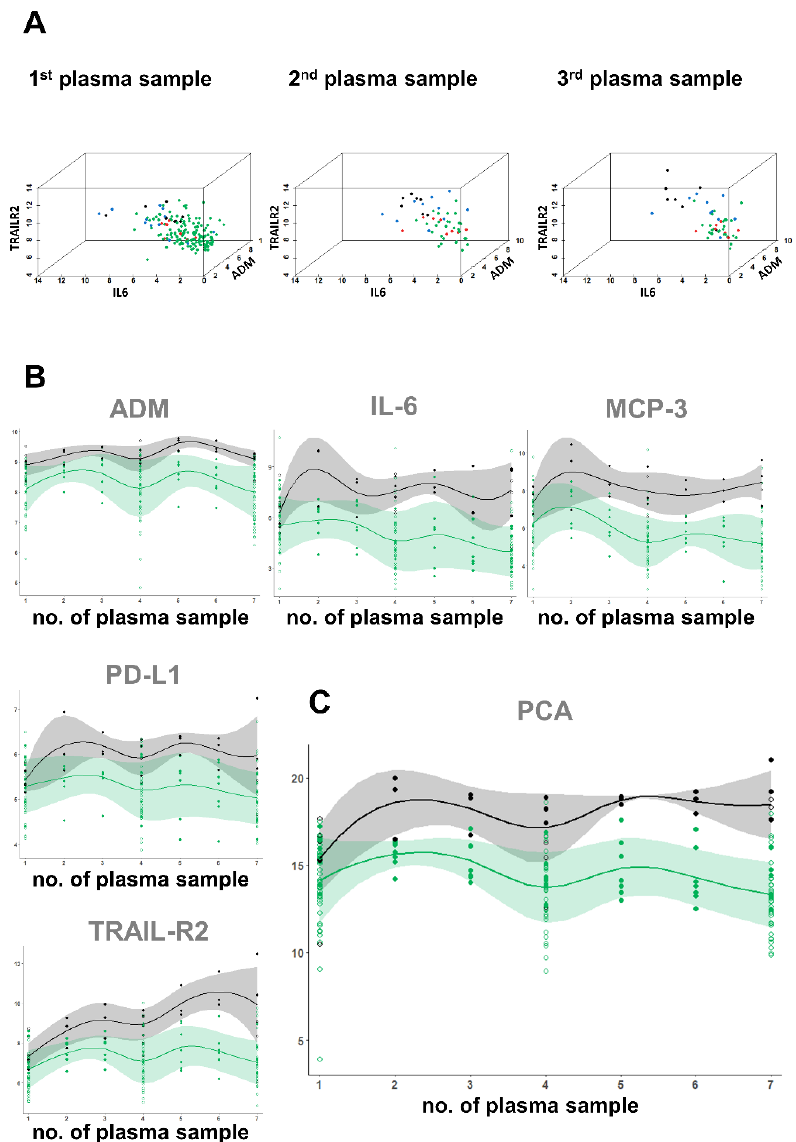
Figure 6. Illustration of predictive protein values and kinetics as well biological variation of proteins during hospital stay—( A ) three-dimensional illustration of predictive protein values. Green dots: non-hospitalized COVID-19; red dots: hospitalized COVID-19 with ICU admission; blue dots: hospitalized COVID-19 with ICU admission and requirement for mechanical ventilation; Black dots: COVID-19 with fatal outcome. ( B ) Kinetics of the five selected markers separately (ADM, IL-6, MCP-3, PD-L1, TRAIL-R2) and ( C ) the PCA based on the combination of the analytes. The x -axis represents seven different time points of plasma procurement, with the first (1) taken at the ED and the seventh (7) isolated prior to discharge or death of the patient. Samples two to six were isolated during the hospital stay at approximately similar time intervals. Depicted are values of all n = 53 hospitalized COVID-19 patients with three time points. For n = 10 (solid dots) patients plasma samples at seven time points were analyzed. Open dots represent patients with three time points. Green dots = discharged patients, black dots = patients with fatal outcome. Shown are data for individual COVID-19 patients with survival (solid green dots = patients with seven time points, open green dots = patients with three time points) and mean values (solid green line) with standard deviation (light green area) and data for individual COVID-19 patients with fatal outcome (solid black dots = patients with seven time points, open black dots = patients with three time points) and mean values (solid black lines) with standard deviation (grey area).